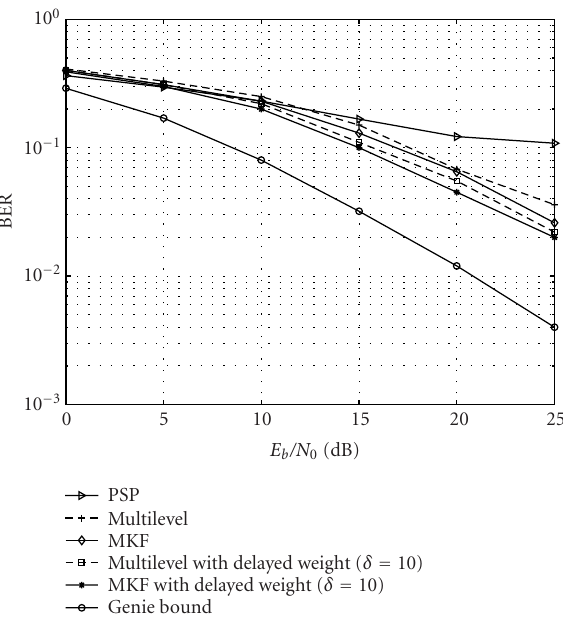
Figure 4: The BER performance of the PSP, the MKF, and the mul- tilevel MKF for di ff erential 16-QAM over flat-fading channels. The delayed-weight method is used with δ = 10.